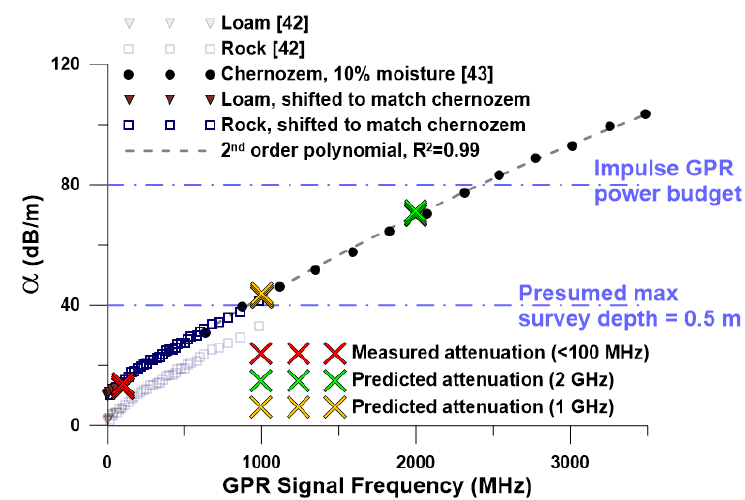
Figure 9. Empirical correction of measured attenuation based on published values [42,43] for earth materials across a range of signal frequencies.